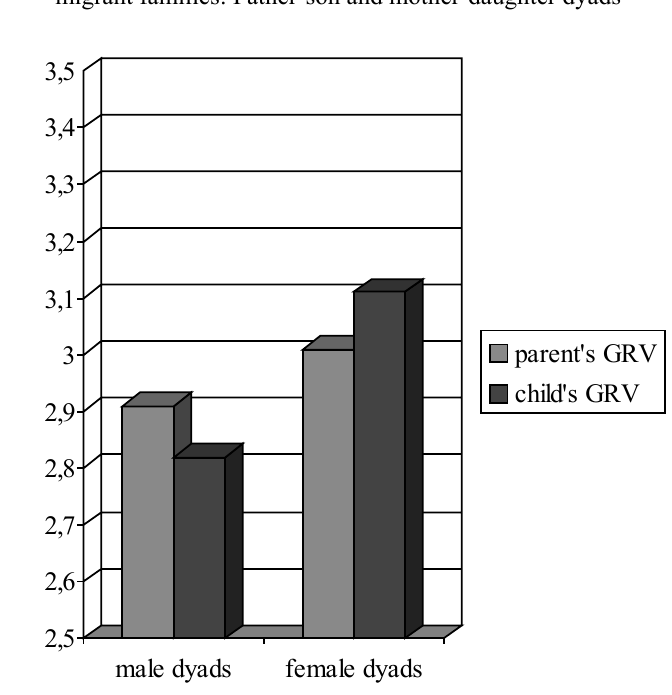
Figure 2. Intergenerational discrepancies in Gender Role Values (GRV) in Turkish migrant families: Father-son and mother-daughter